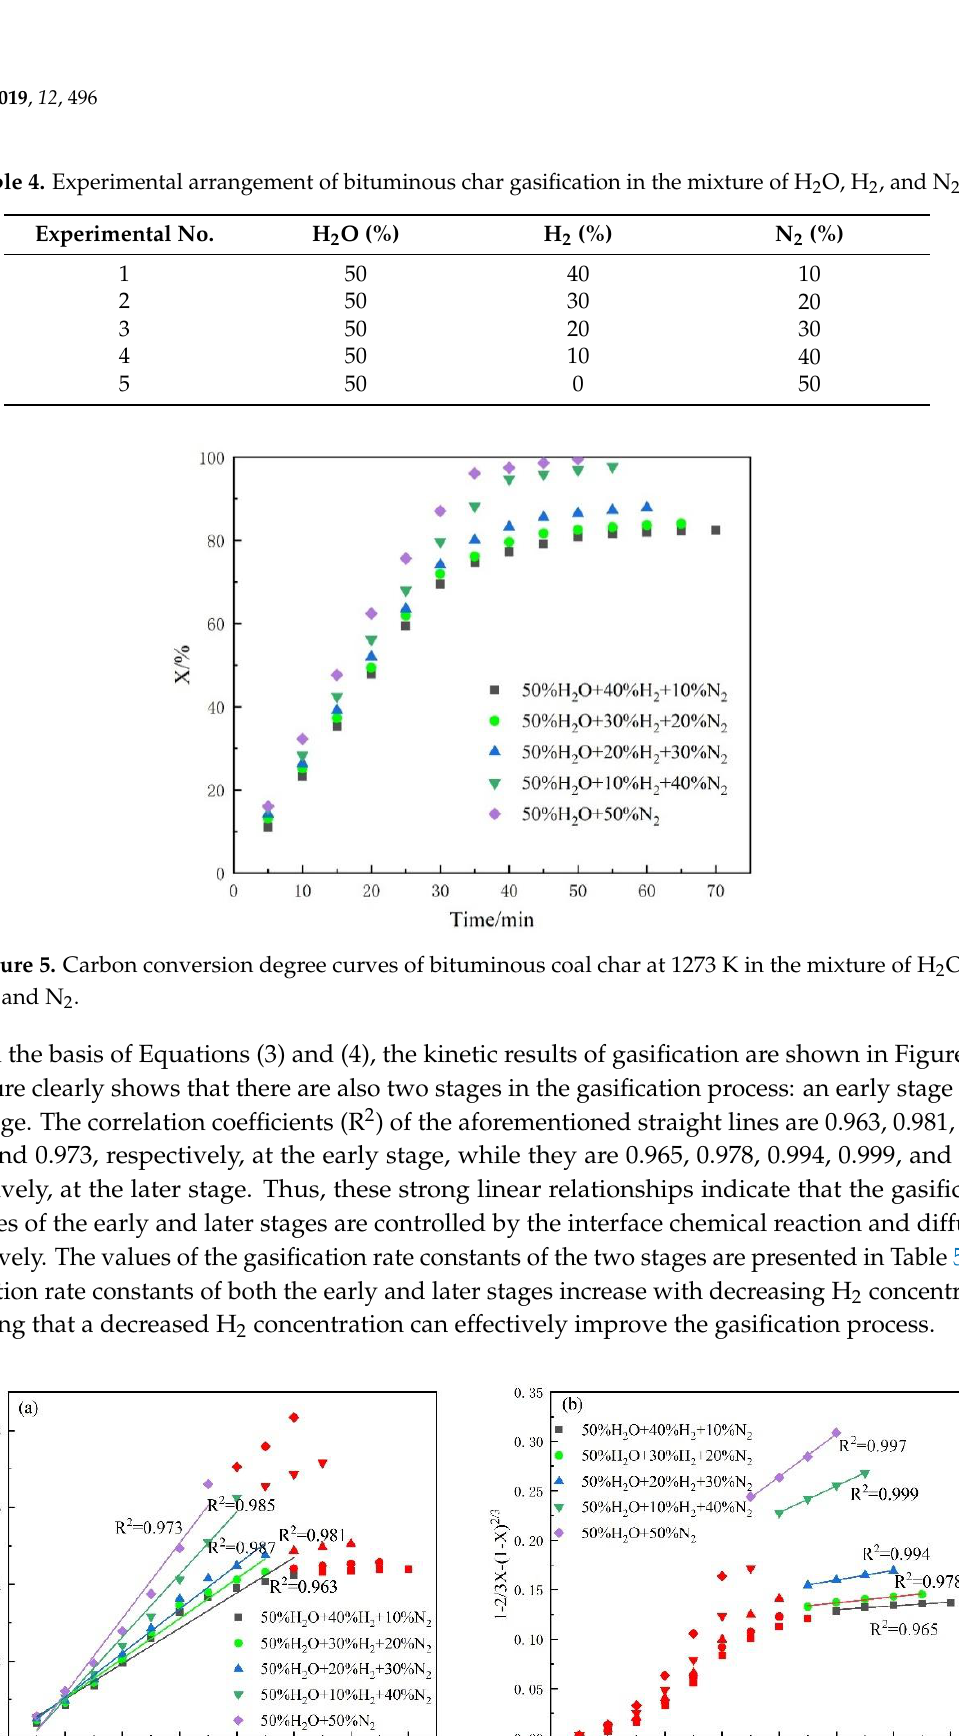
2 2 X − ( 1 − X ) 2 3 vs time with various 𝑋 − (1 − 𝑋) 3 3 vs time with various 3 2 2 𝑋 − (1 − 𝑋) 3 vs time with various 3